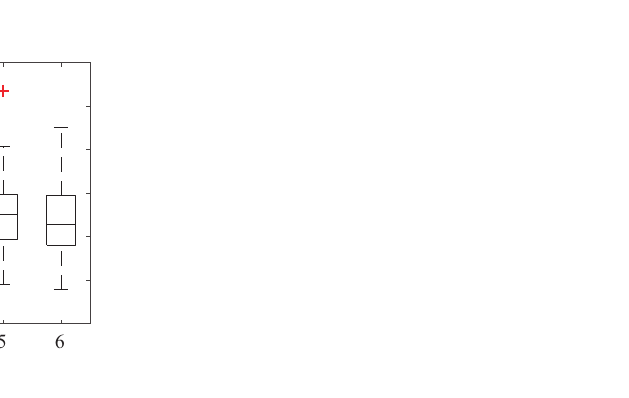
Figure 6. Performance of the analytical models in axial load capacity: error box plot diagram. (1) Lam and Teng [10]; (2) Tan [20]; (3) Maalej et al. [27]; (4) Lignola et al. [22]; (5) Triantafillou et al. [31]; (6) Vuggumudi et al. [32].